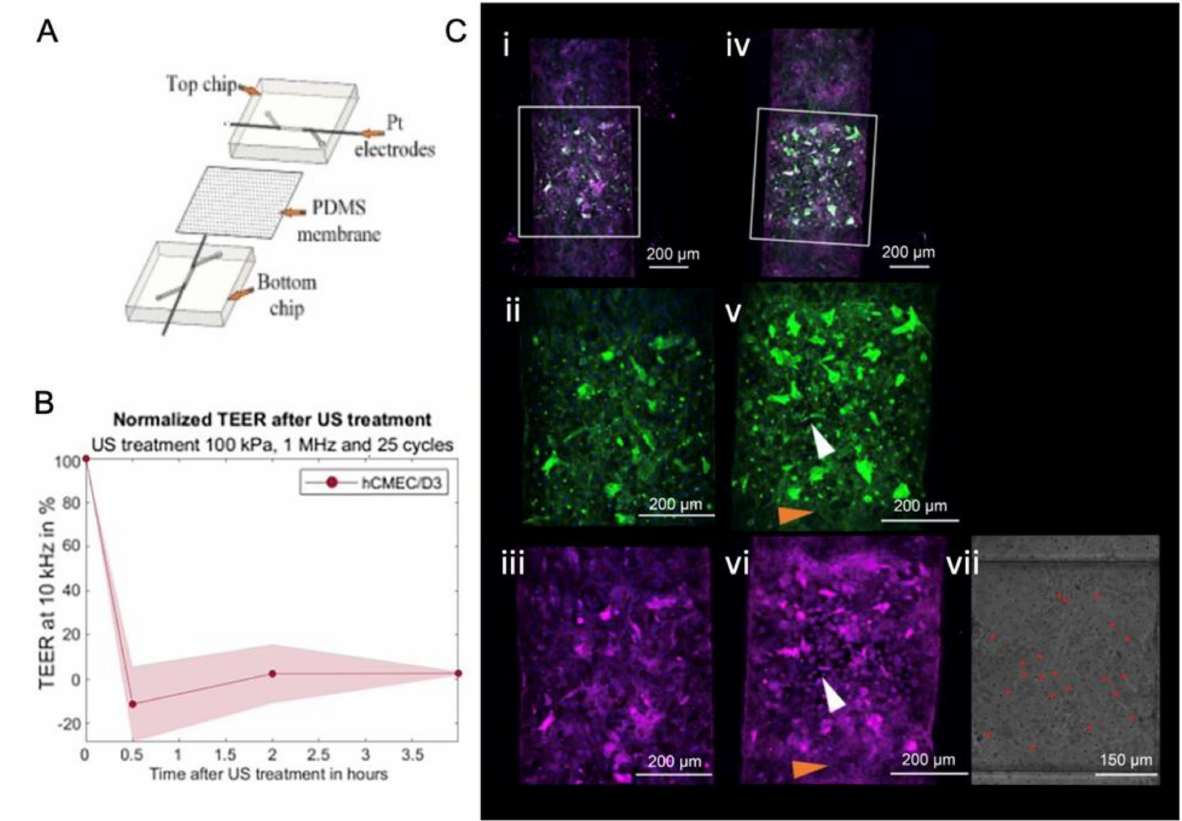
Figure 10. A sandwich model that mimics the BBB in vitro was employed for the study of the ultrasound mediated opening of vascular barriers. ( A ) The structure and components of the model. ( B ) Normalized TEER value changed after focused ultrasound and microbubble treatment (FUS + MB) [127]. ( C ) Channels with a monolayer of hCMEC/D3 exposed to ultrasound ( i–iii ) with- out microbubbles, ( iv – vi ) with microbubbles. FUS + MB treatment of 25 cycles, 1 MHz, and 100 kPa, the red dots in ( vii ) denote microbubbles, white arrows in ( v , vi ) designate the same regions of cells that responded to FUS + MB treatment, with ZO-I stained in pink, nuclei stained in blue, and F-actin stained in green